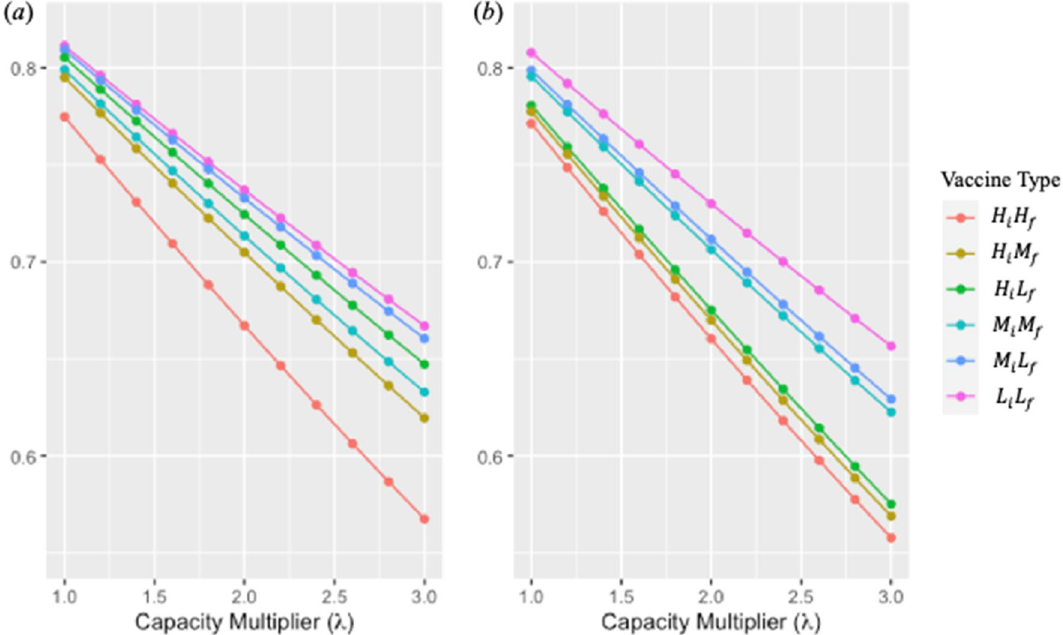
Figure 2. Infection attack rate under different capacity multipliers with different vaccine types when mutation time is ( a ) day 10 and ( b ) day